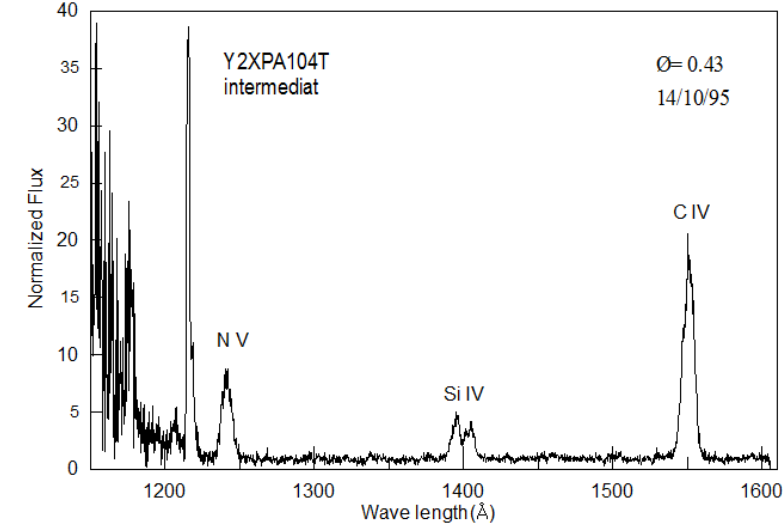
Fig. 2 HST spectrum of DQ Her with intermediate flux at phase